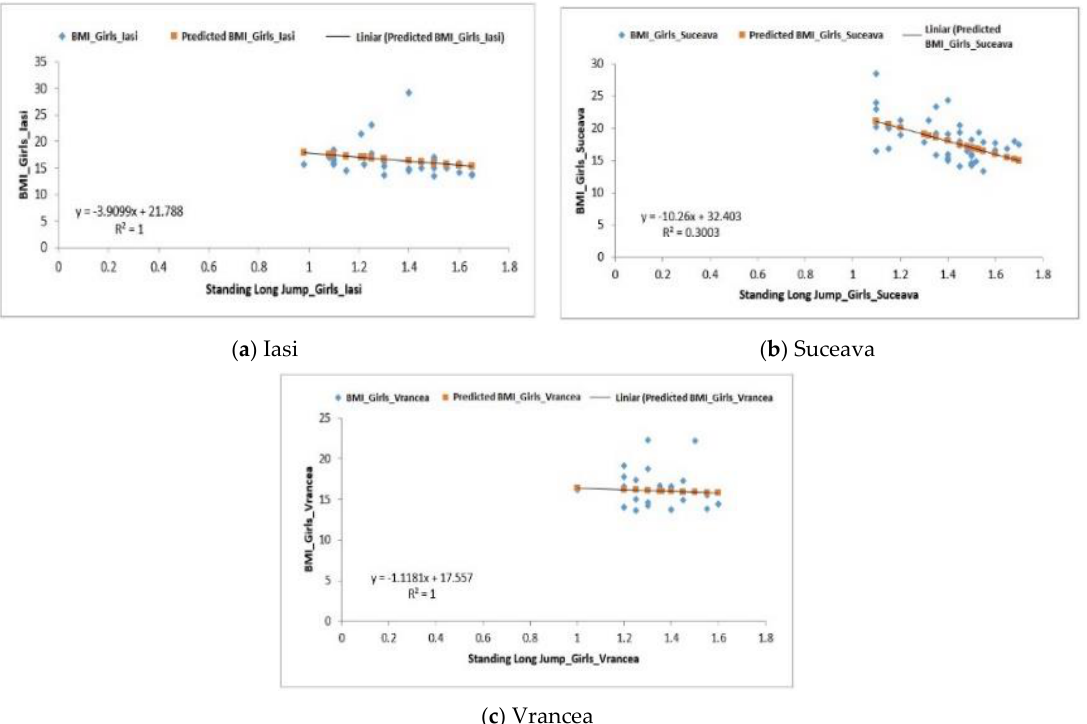
Figure 6. Relationship between the BMI and the standing long jump test for the female subjects in the three regions.